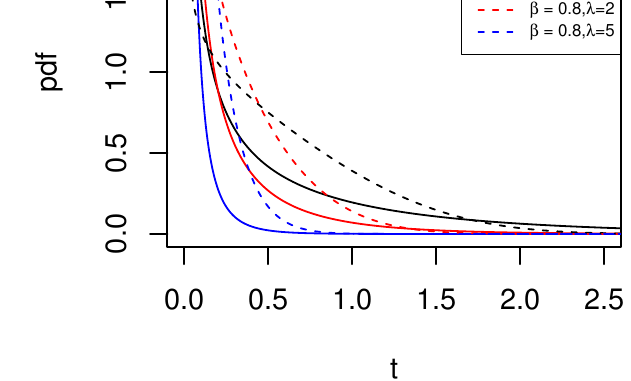
Figure 2. pdf of Chen ( t ; β , λ ) ,0 < β < 1.